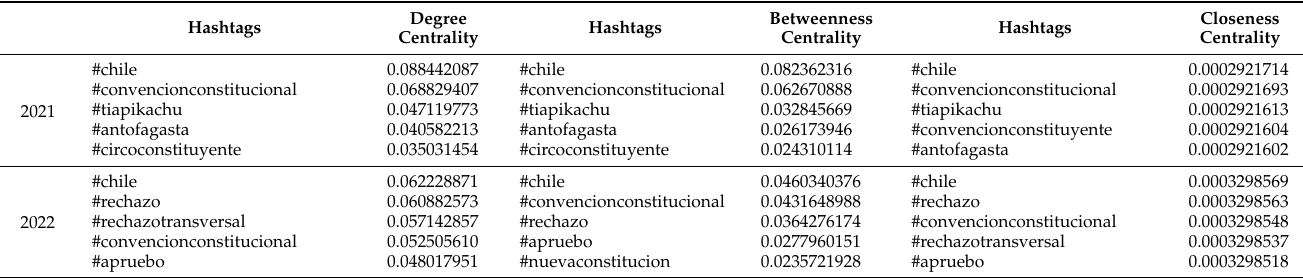
Table 5. Five highest hashtags in local network metrics for “Independientes”.